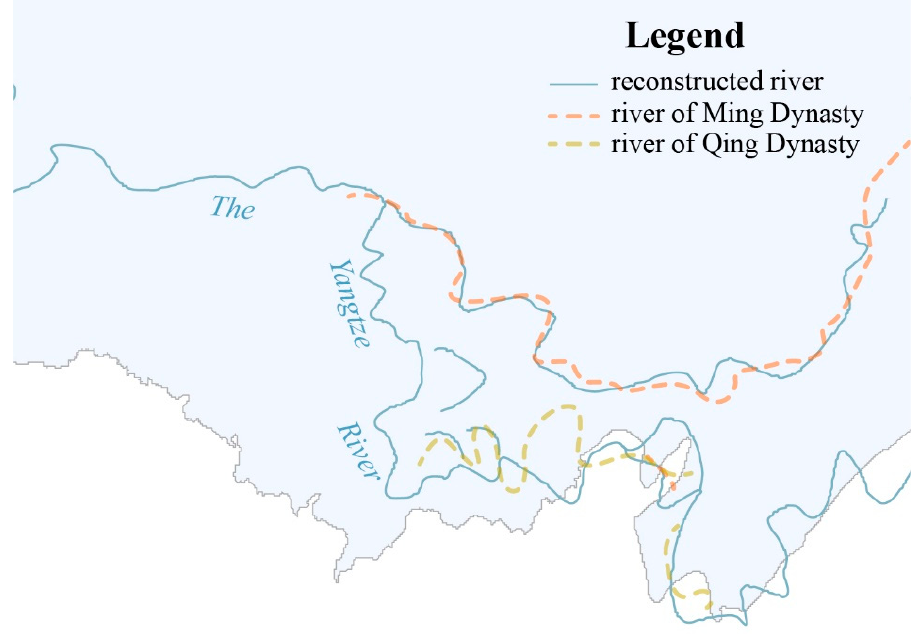
Figure 10. Map of river course dynamics about the Yangtze Figure 10. map of river course dynamics about the Yangtze River.